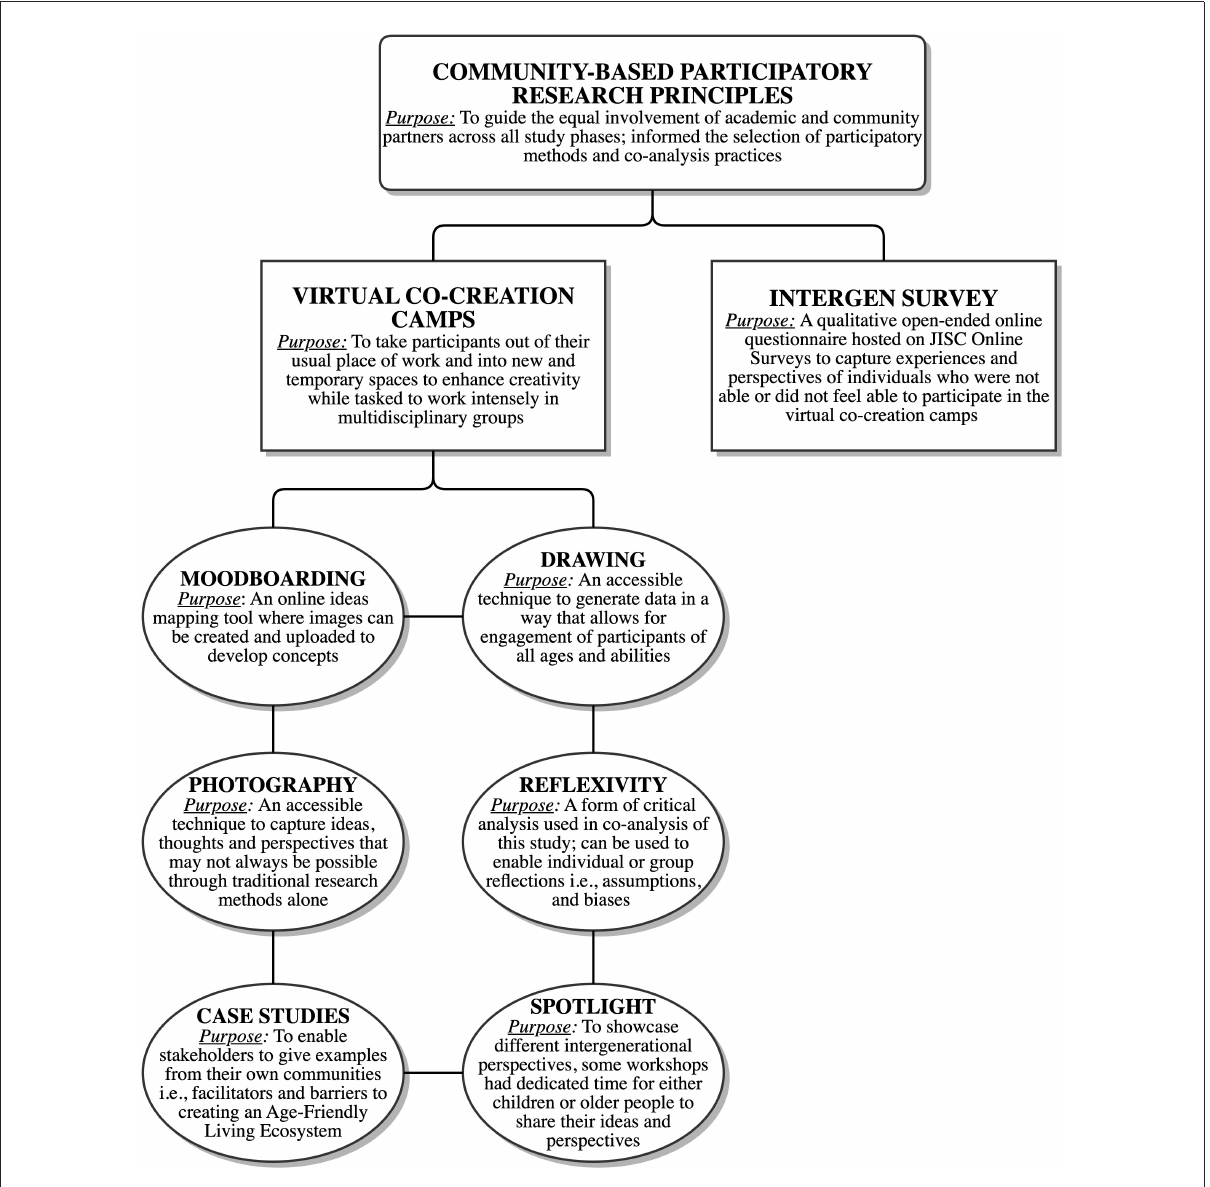
FIGURE2 A schematic of the study methodology that includes key research principles which guided the overall participatory nature of the study and the methods used to co-create knowledges and